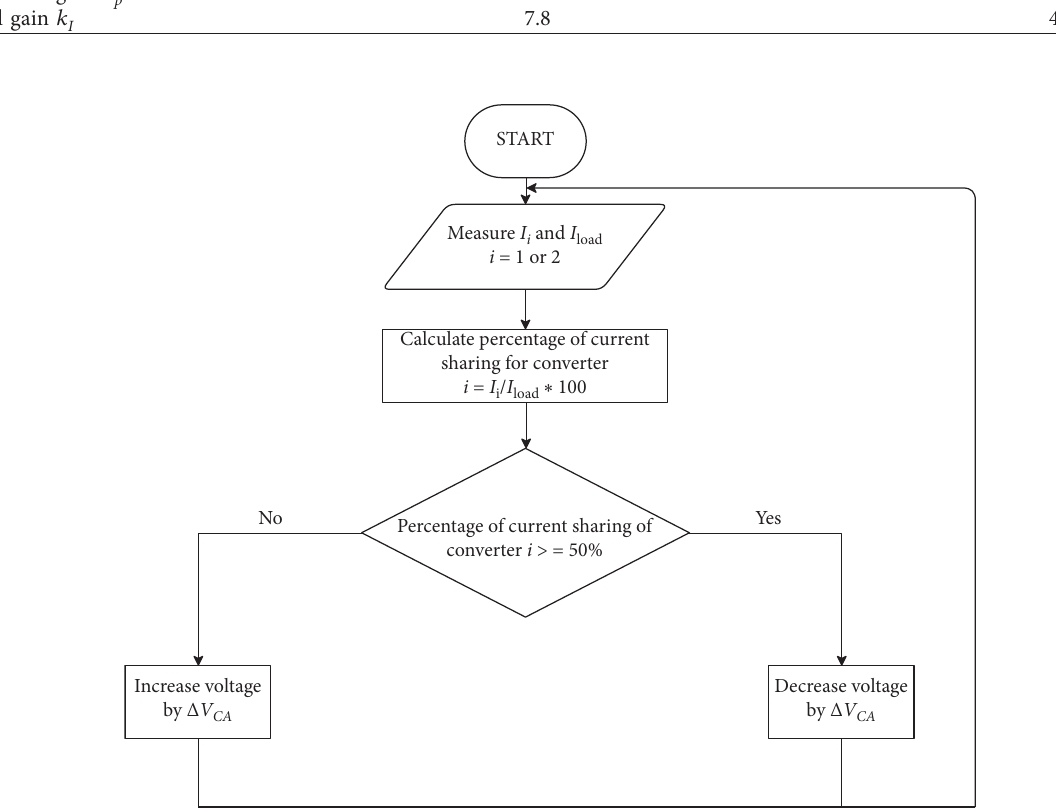
Figure 5: Flow chart of the proposed